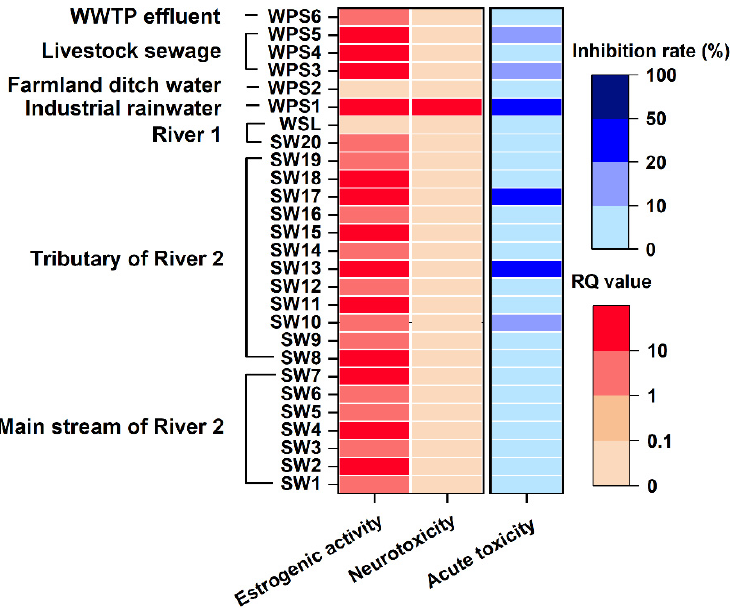
Figure 6. Acute toxicity, estrogenic activity, and neurotoxicity risk assessment of water samples in the study area.